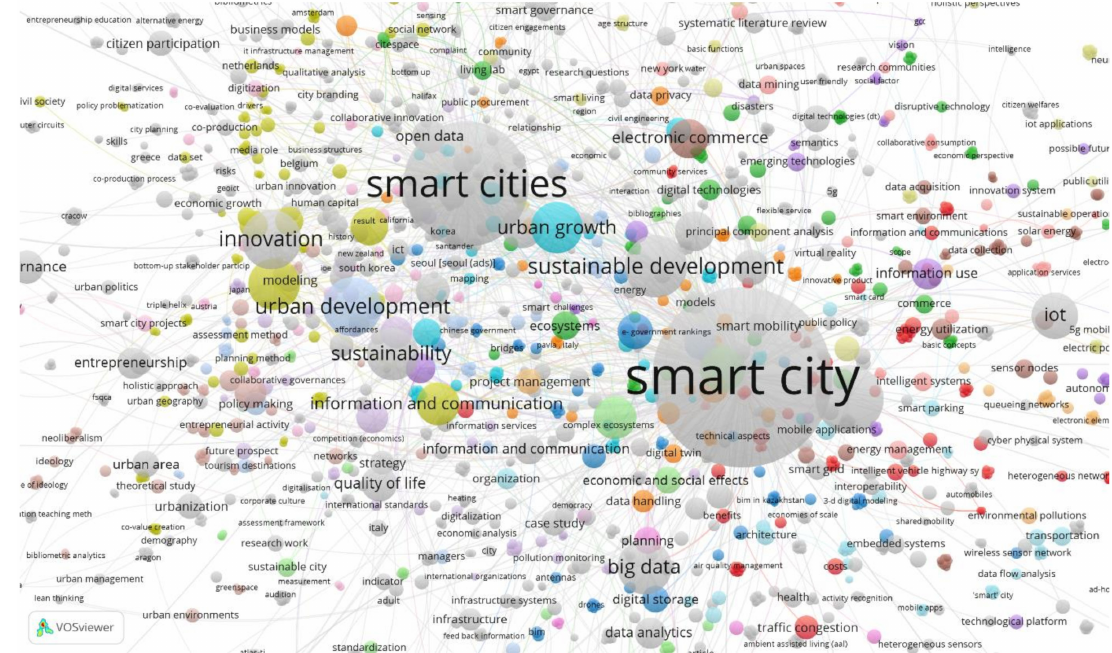
Figure 9. Visualization of a collection consisting of